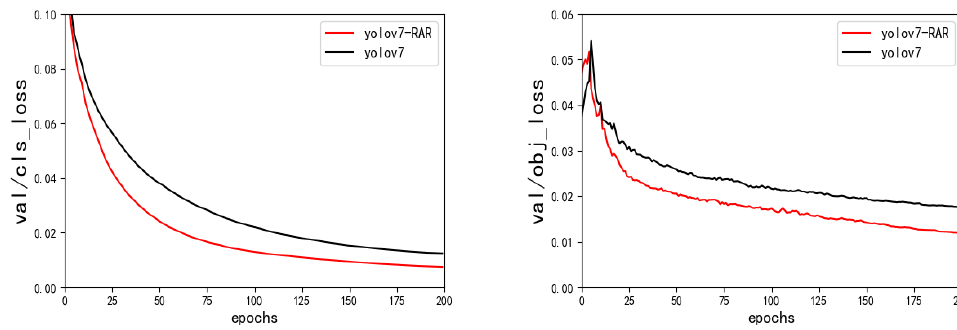
Figure 14. Results of YOLOv7-RAR ablation experiment. Table 6. YOLOv7-RAR network performance.